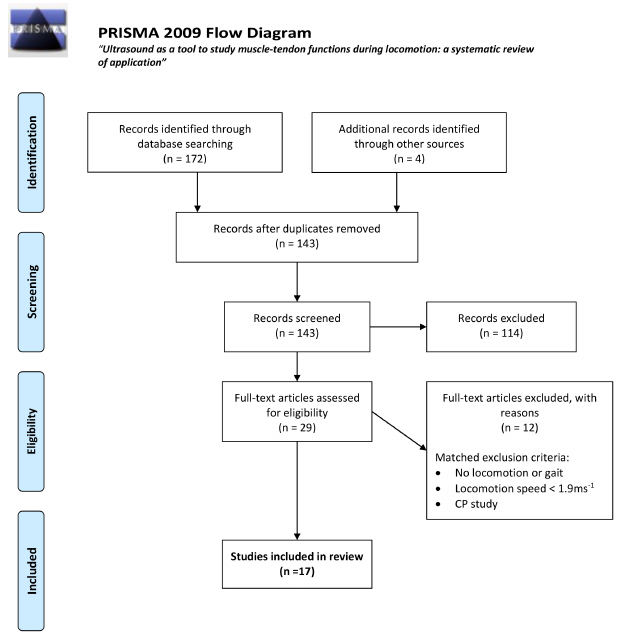
Figure A1. The present review followed the PRISMA Flow Diagram